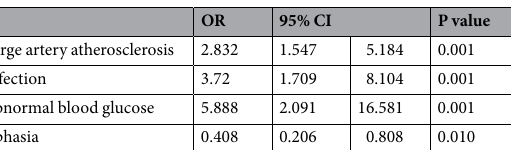
Table 5. Multivariate regression analysis to identify the independent risk factors for recurrent